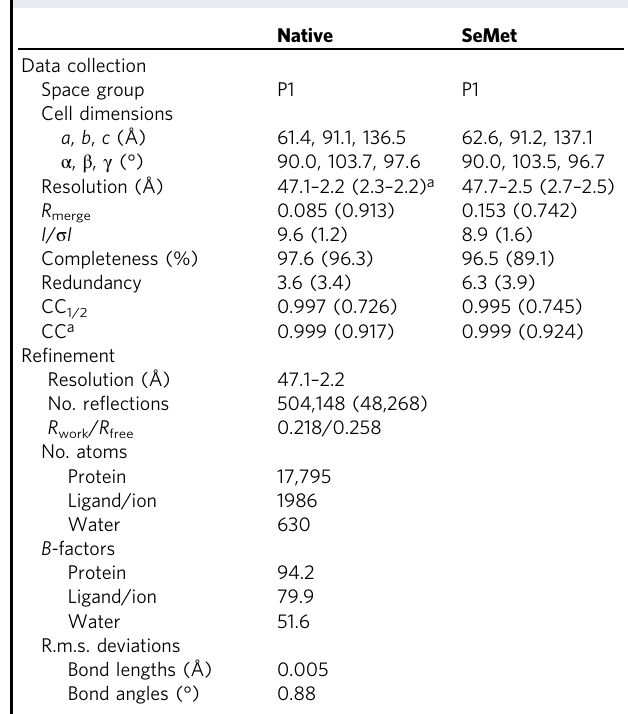
Table 1 Data collection, processing, structure solution, and re fi nement